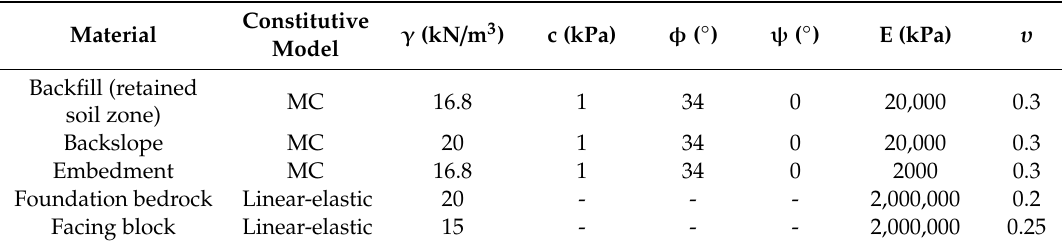
Table 2. Input parameters for validation analysis